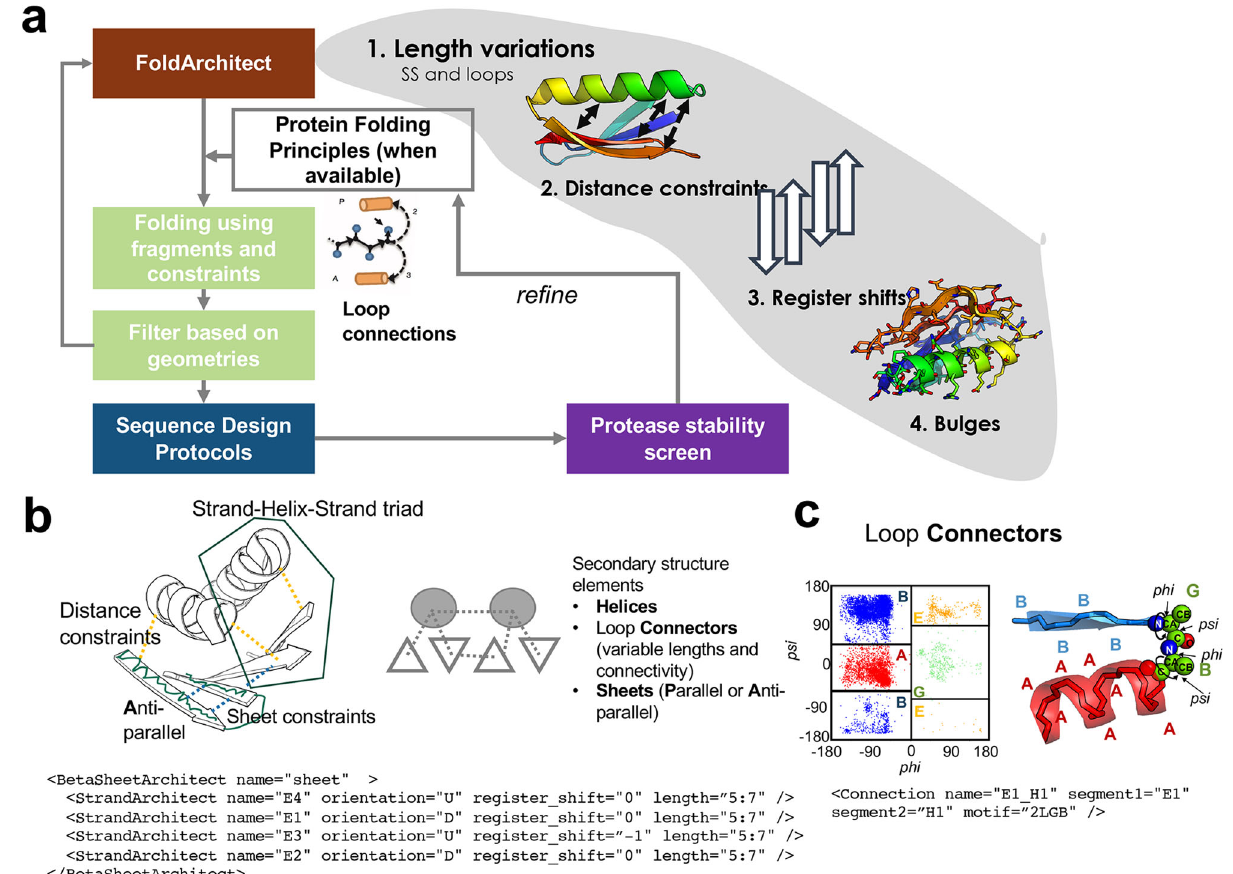
Fig. 1 | Overview of the FoldArchitect and RosettaScripts integration. a The FoldArchitect accepts user speci fi cation, which includes length ranges of second- arystructure(SS)andloops,aswellashowthedistanceconstraintsareapplied(for instance, harmonic constraints). In addition, register shifts and beta bulges can be speci fi edtointroducelargercurvatureintobetasheets.Wethenusethepreviously reported fragment insertion protocol 1 and fi lter for geometrically realistic back- bone conformations before designing the sequence of the new construct. After sequence design, the decoys are screened for their stability using varying con- centrations of trypsin and chymotrypsin. The information gained from the stable